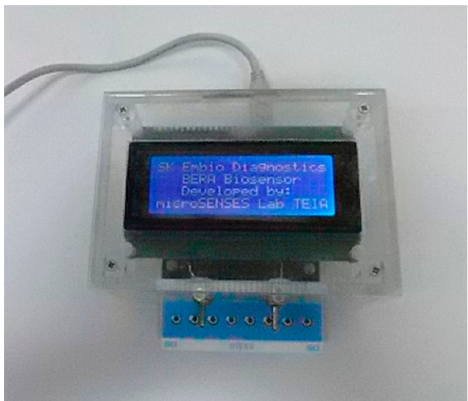
Figure 5. The handheld TCA screener with the disposable eight-channel electrode strip attached to the main measuring unit.